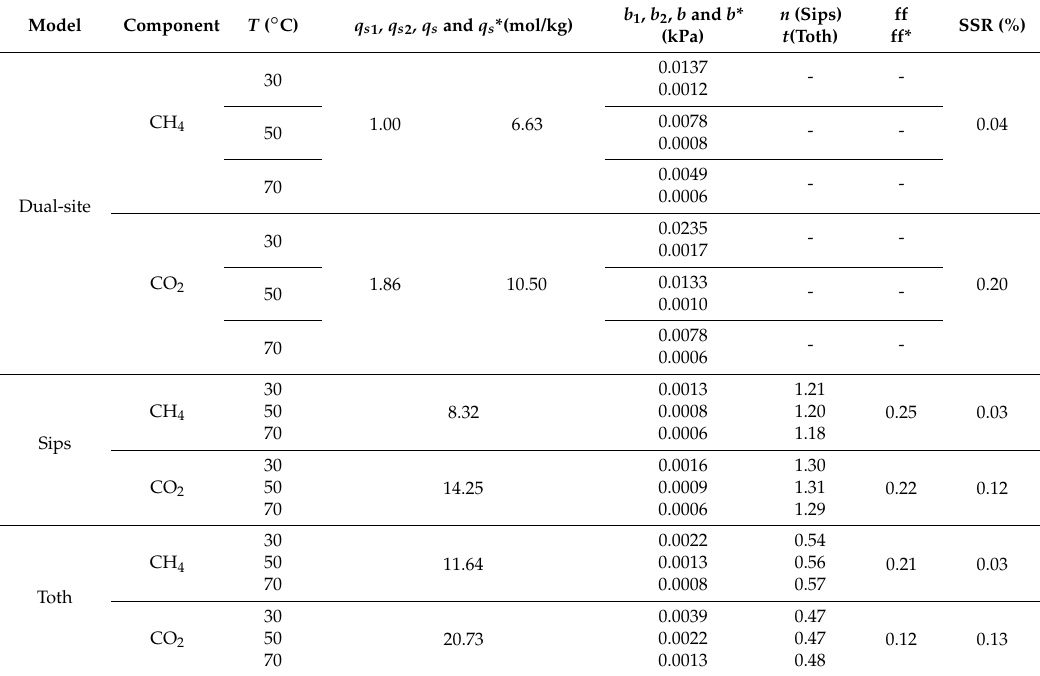
Table 3. Sips, Dual-Site Langmuir, and Toth-fitting parameters models to CO 2 and CH 4 pure component adsorption isotherms for the CNS-activated